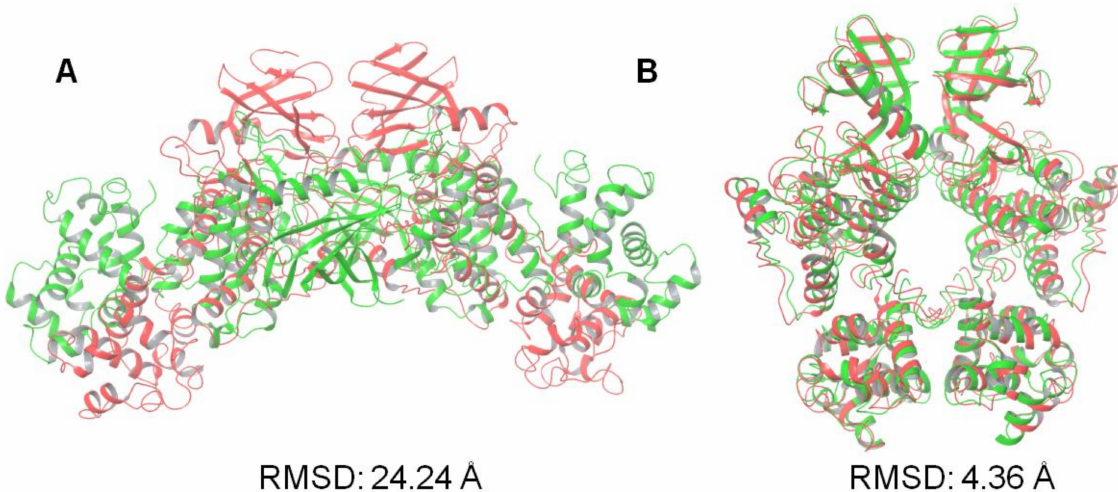
Figure 4. Illustration of the protein–protein docking results of KIRA-containing IRE1 monomers (PDB code: 4U6R). Values shown are the RMSD in angstrom of the positions of the C α atoms of the best-scoring docked pose (green) against the native IRE1 dimer structure in ( A ) face-to-face (PDB code: 3P23) and ( B ) back-to-back (PDB code: 4YZC) conformation